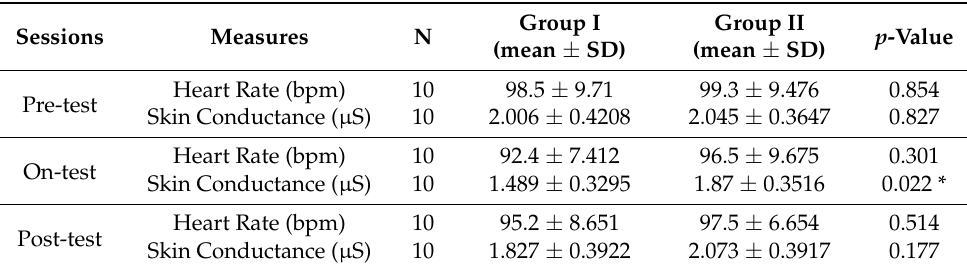
Table 1. The mean value of heart rate variability and skin conductance alterations on the pre-test, on-test, and post-test of group I and